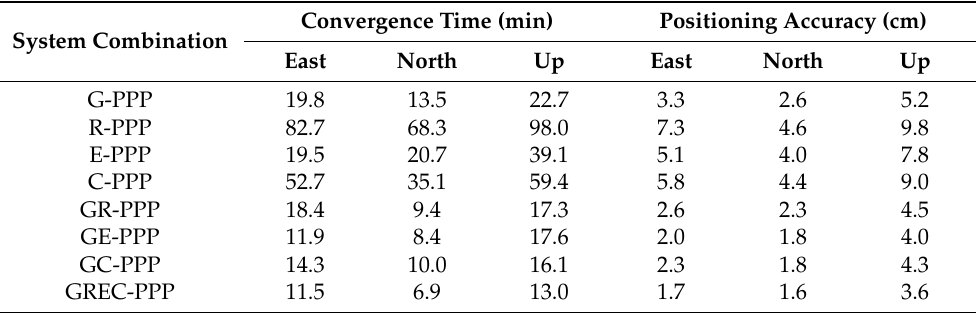
Table 16. Kinematic positioning accuracy and convergence time of real-time PPP (long-term perfor- mance of PPP based on daily observations) with CNES products for different system combinations using the datasets from 29 stations spanning a